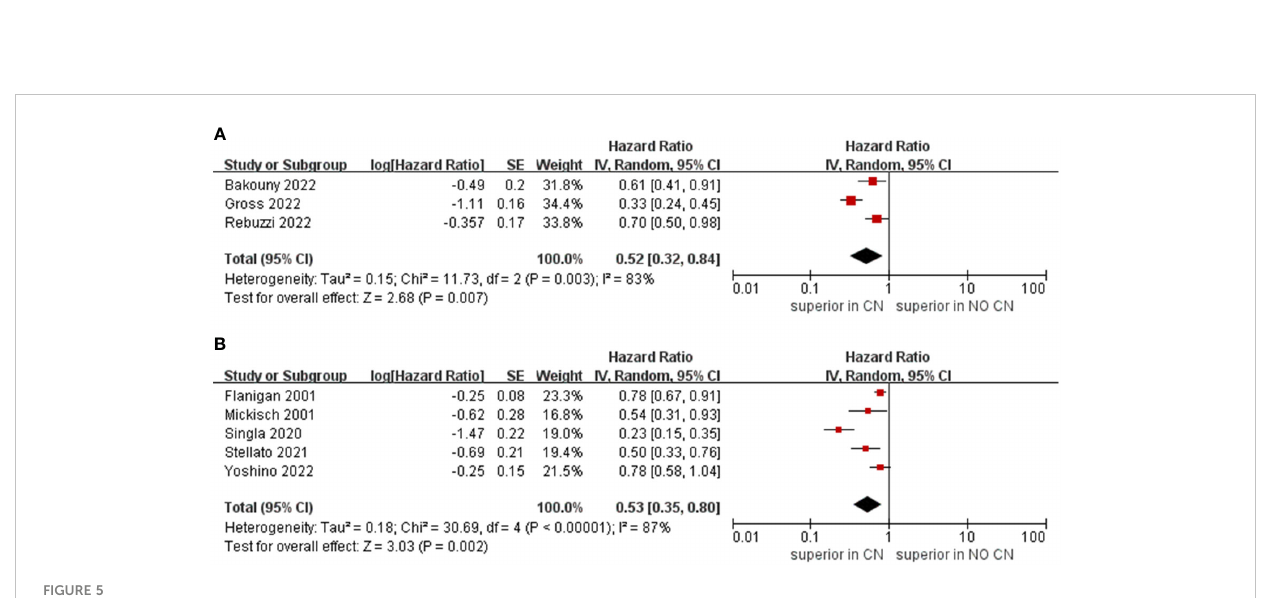
FIGURE 4 Forest plots of overall survival in subgroup analysis. (A) ICIs, (B) IFN-alfa.